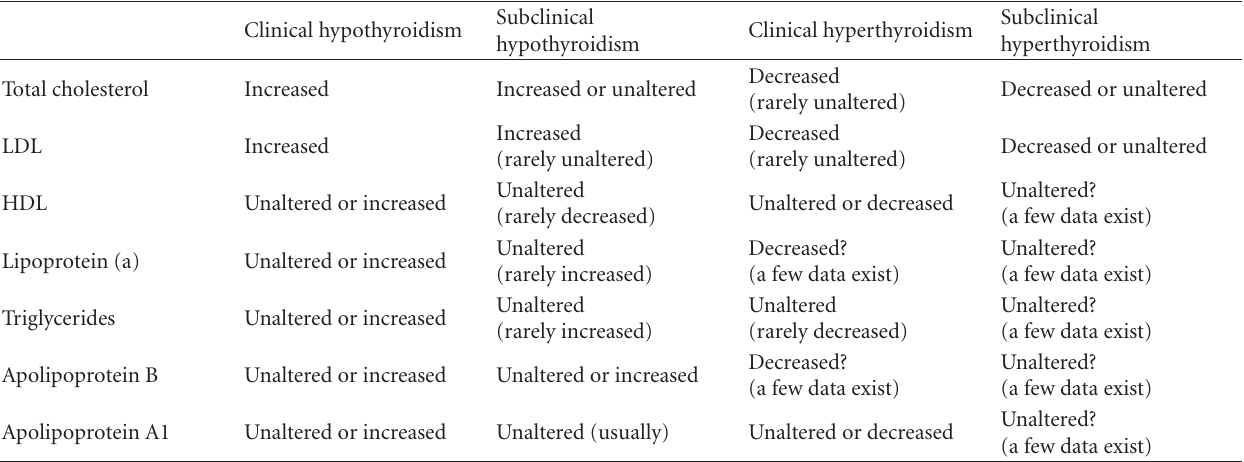
Table 2: Lipid abnormalities in clinical and subclinical thyroid